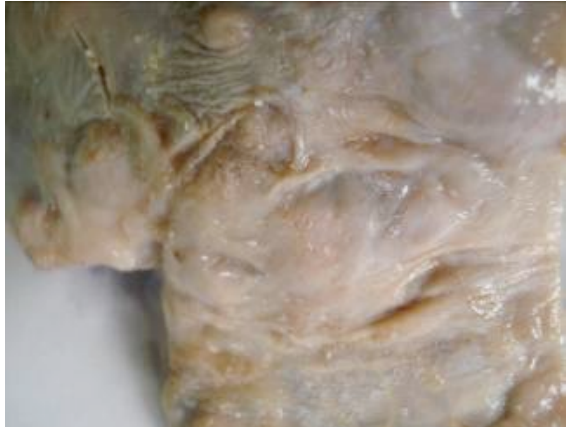
Image 2. Lung of Rhesus Macaque showing caseous nodules and